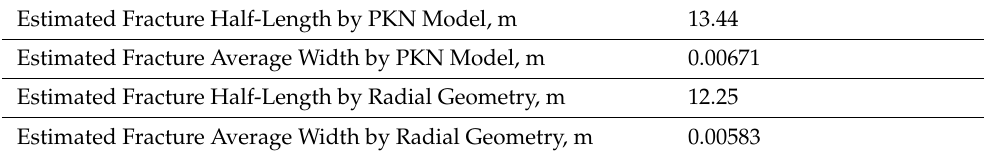
Figure 13. Bottom hole pressure field-smoothed vs. simulation results; pressure derivative field- smoothed vs. simulation results. Table 3. Fracture geometry estimation by numerical